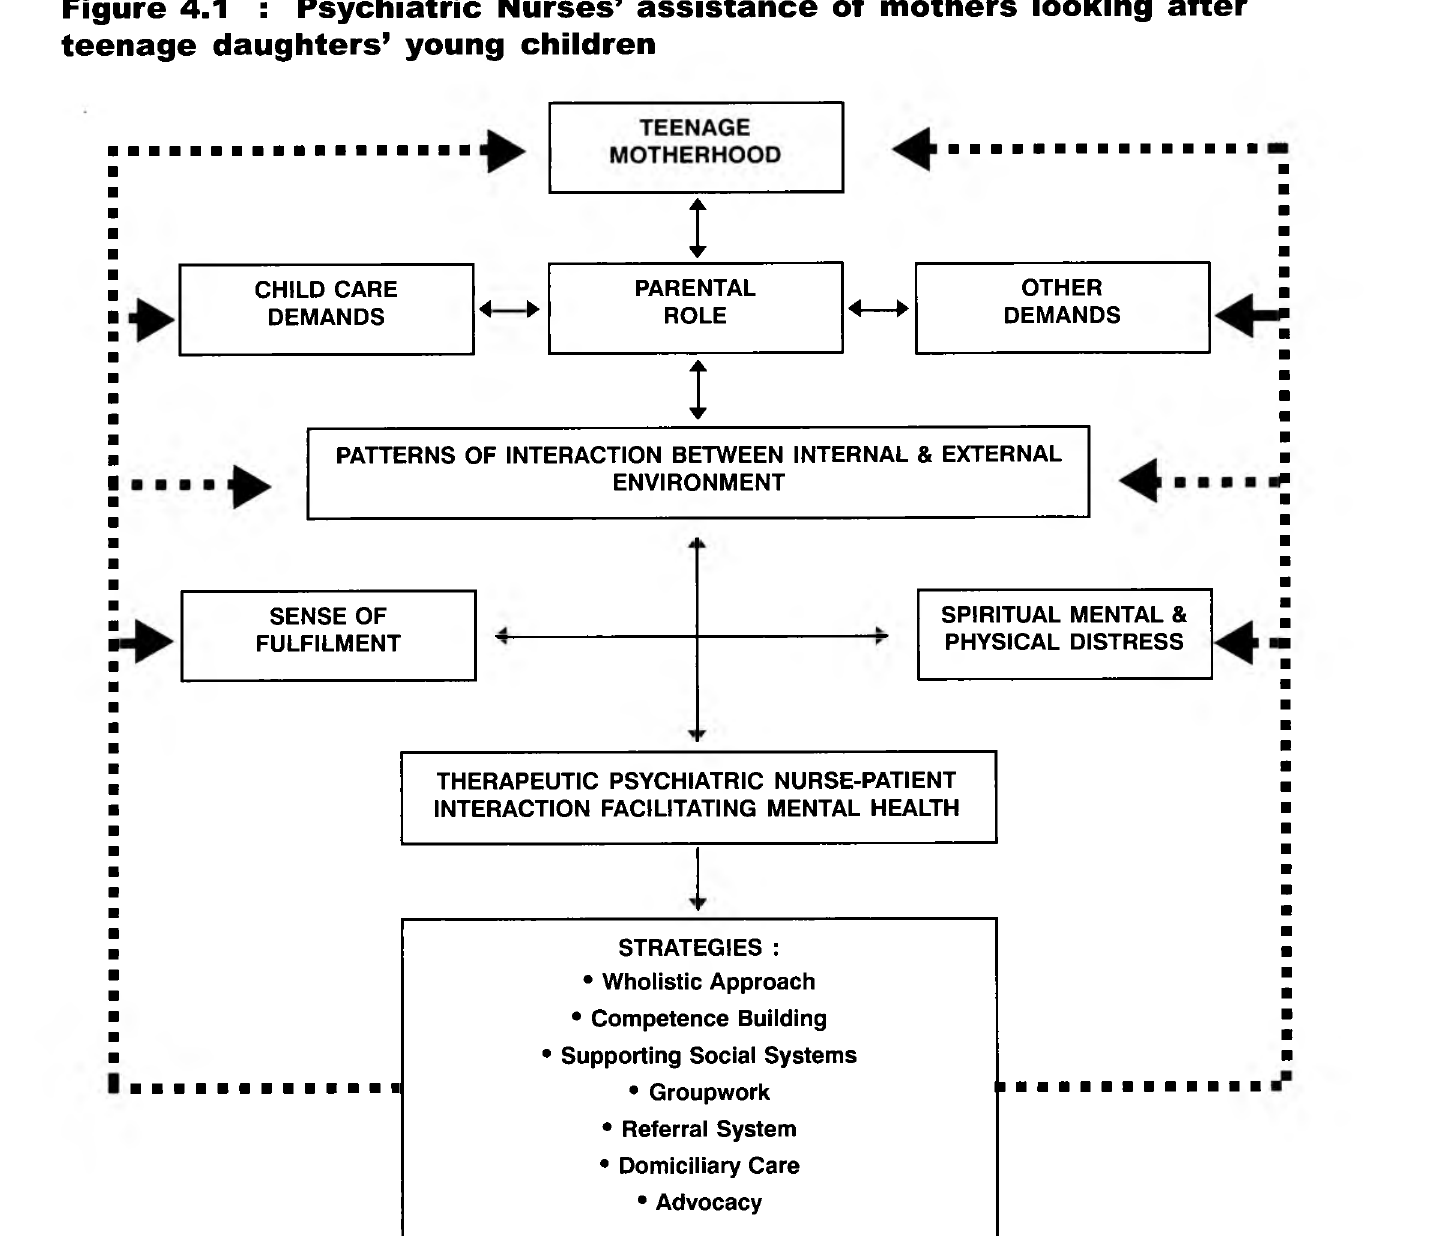
figure depending on the patterns of in­ teraction between the internal and exter­ nal environment of a respondent at